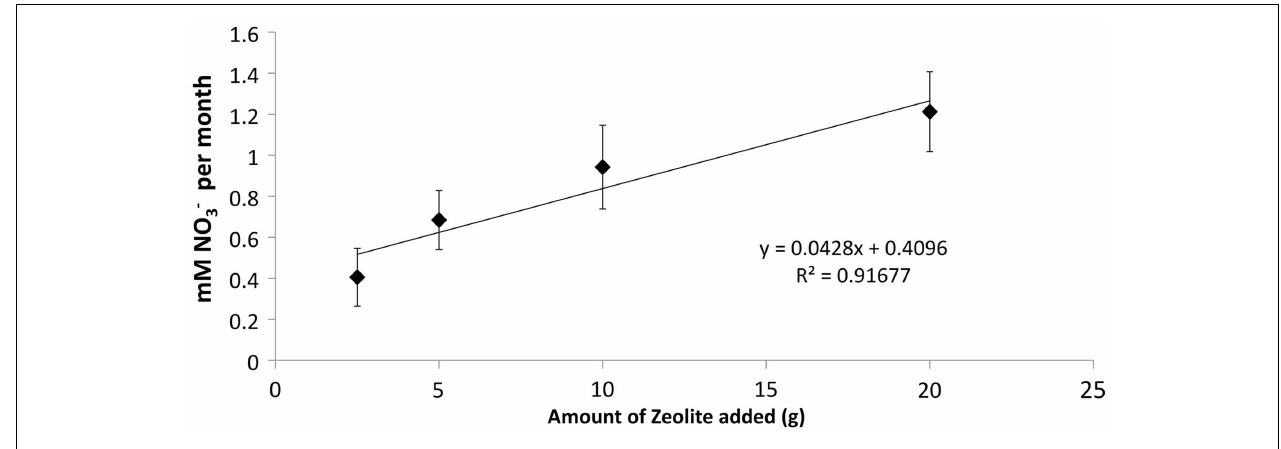
incubated at 4˚C. Rates and standard deviations were determined from duplicate measurements of the four samples ( n = 8) over time.